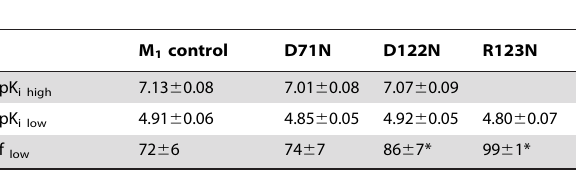
Table 6. Effects of single amino acid mutations of M 1 receptor on the binding parameters of